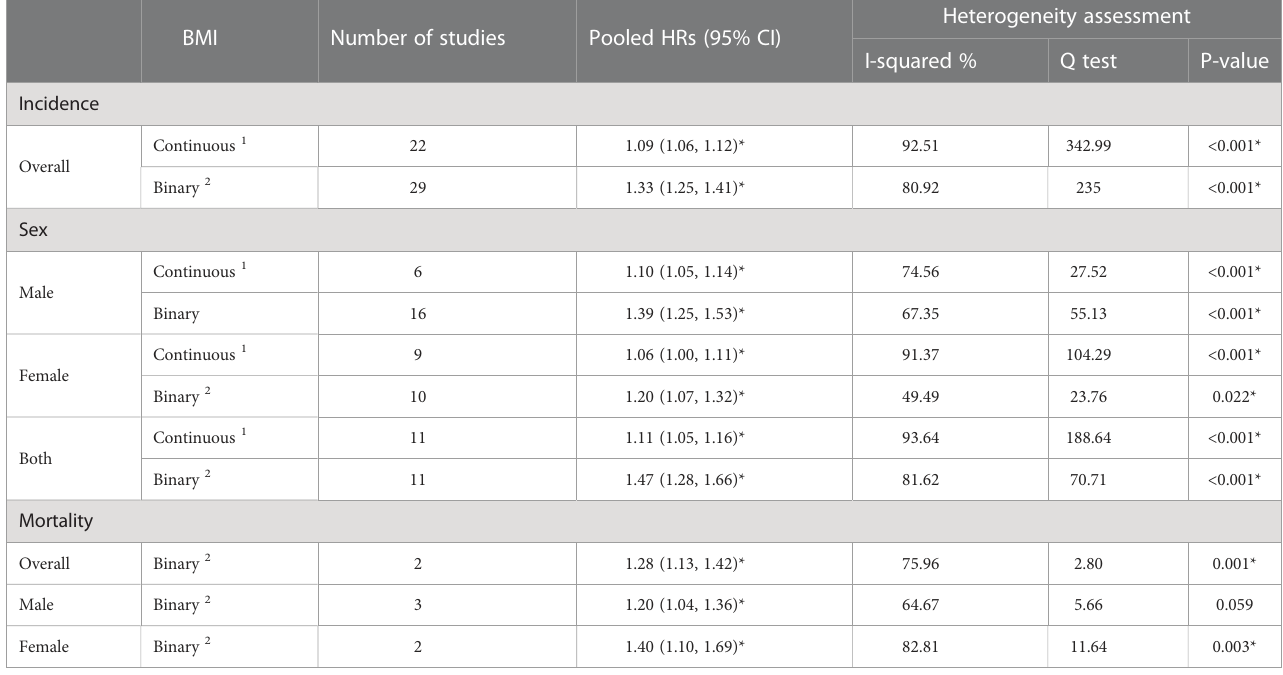
TABLE 1 Meta-analysis of the association between obesity – related indices in children and adolescents with the incidence and mortality of all- cause cancer in adulthood.